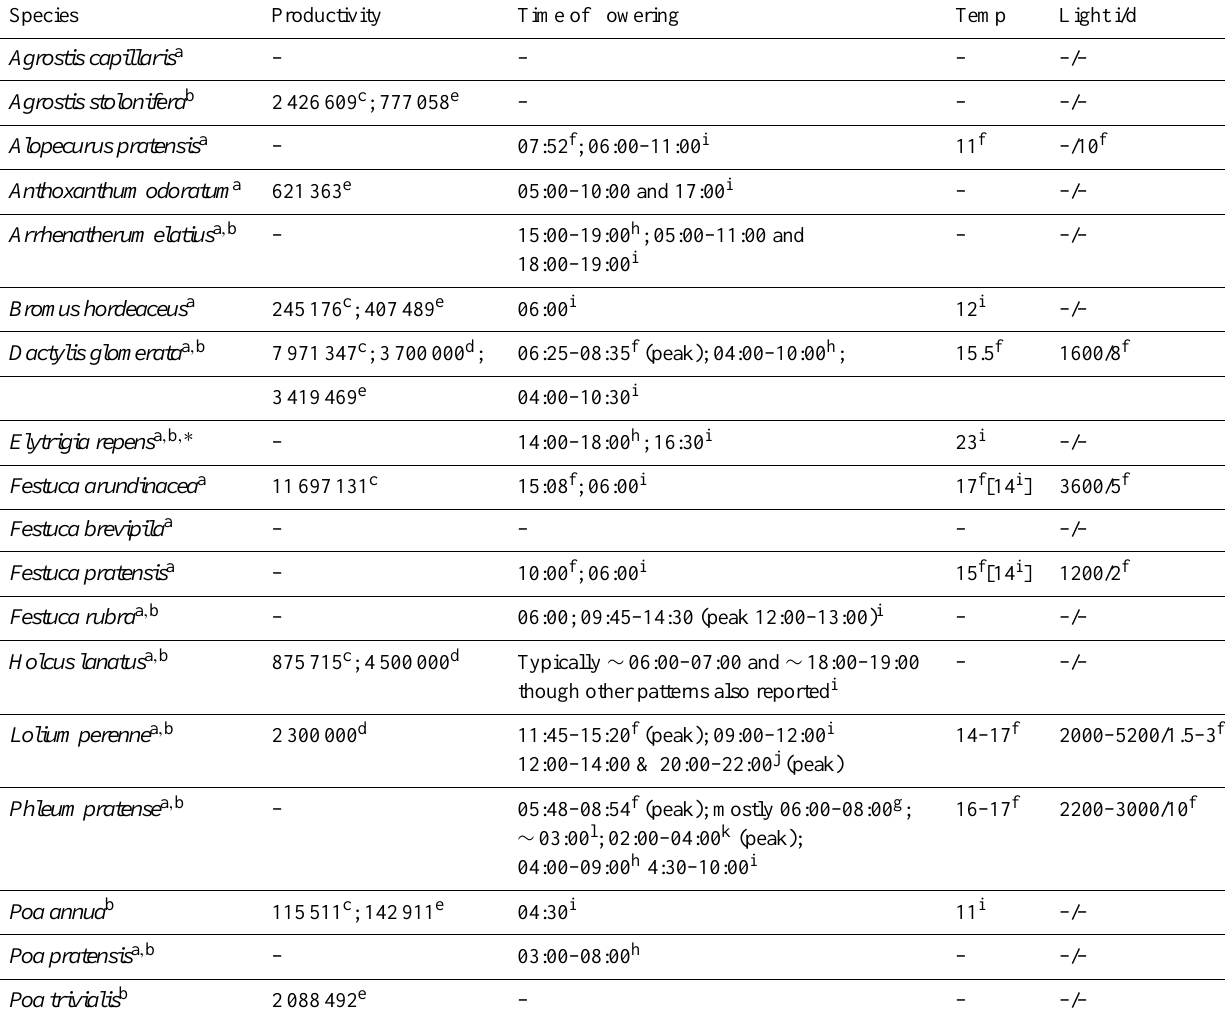
Table 2. Grass species that are likely to be present in and around Aarhus. Constituent species are listed by a Frederiksen et al. (2006) as “common” or “very common” along roads and railways and in parks, and/or were found by b Hald (2011) to be common in the city of Copenhagen. Details of productivity (grains/inflorescence c , e or spike d – note that an inflorescence consists of one or more spikes (Guinther, 2013)), time of flowering (range gives period of flowering & hour denotes time of peak flowering, unless otherwise indicated), minimum temperature threshold ( ◦ C) that must be exceeded in order for flowering to occur (square brackets indicate temperature that induces maximum liberation), and minimum light intensity (i – foot candles) and duration (d – hours) necessary to initiate flowering. Information is derived from the following sources: c Prieto-Baena et al. (2003), d Smart et al. (1979), e Aboulaich et al. (2009), f Emecz (1962), g Ogden et